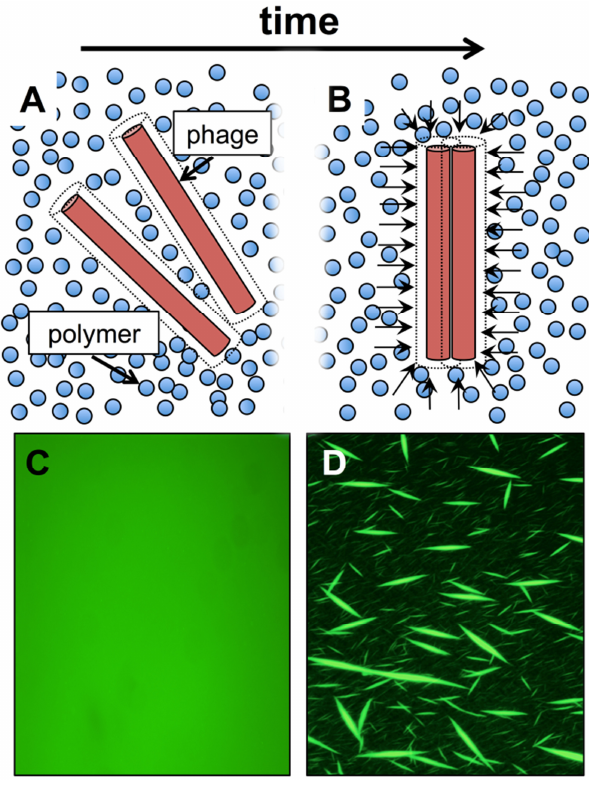
FIGURE 1: Schematic of how depletion attraction drives liquid crystal assembly from Pf phage within polymer-rich environ- ments. (A) Dashed lines around phage particles represent an ex- clusion volume not accessible to the polymer coil’s center of mass. When phages are dispersed, the volume inaccessible to the polymers is maximized. (B) When phages come into close proximi- ty to each other, their exclusion volumes overlap, increasing the total volume accessible to the polymers. This maximizes the en- tropy of the system. Arrows represent an osmotic imbalance that polymers exert on the liquid crystalline phage bundle. This osmot- ic pressure is what physically holds the liquid crystal together. (C) Fluorescently labeled Pf phages (green) are initially dispersed when mixed with the host polymer hyaluronan. (D) As time pro- gresses, the phages form liquid crystalline